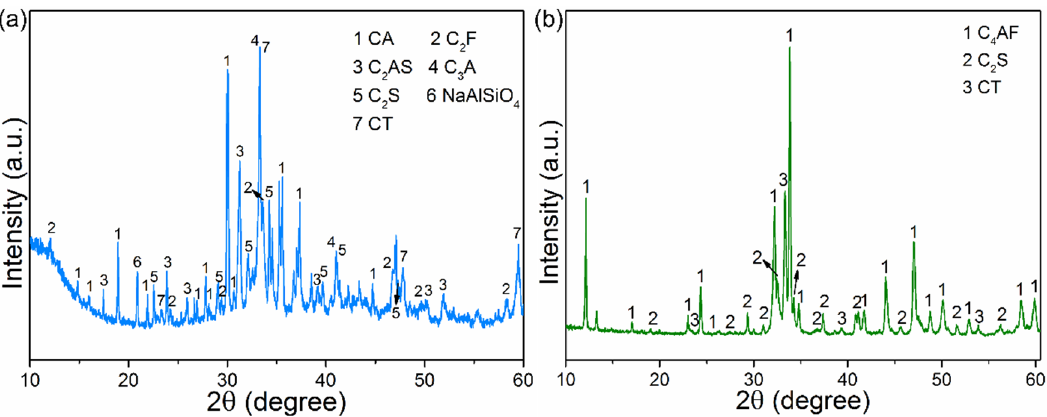
Figure 11. XRD patterns of the sintered samples: the raw red mud ( a ), and the dealkalization red mud ( b ).